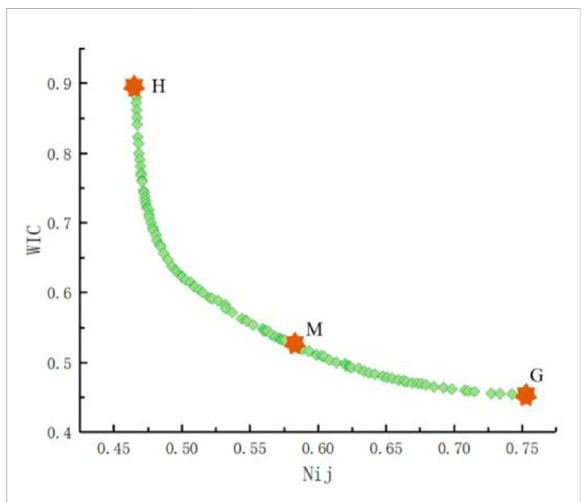
FIGURE 7 Pareto frontier of the optimal solutions of the parameters of the pre-tensioned force-limiting seat belt.